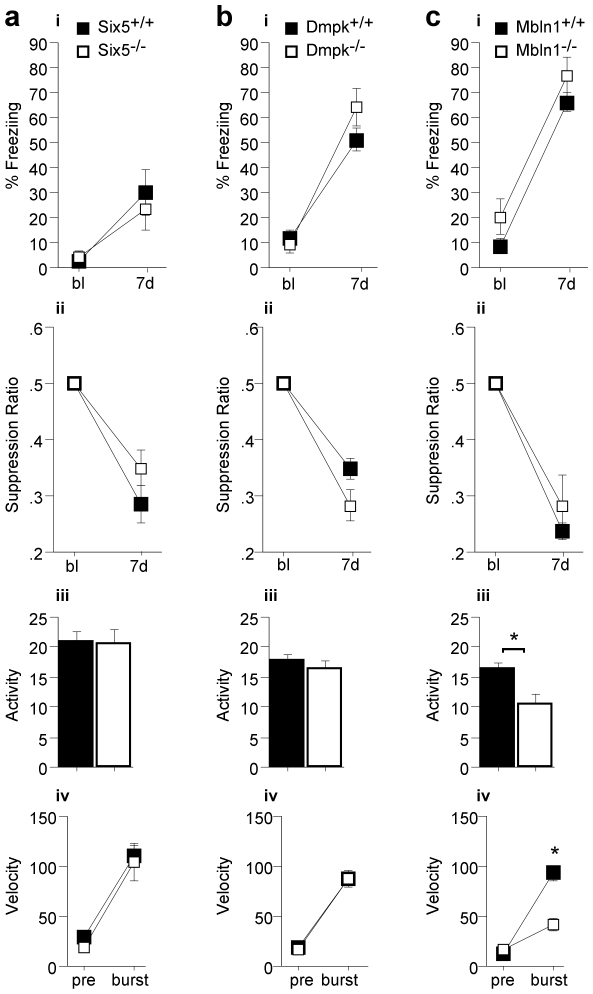
Inactivation of Six5, Dmpk or Mbnl1 does not affect Pavlovian contextual fear conditioning.The percent time freezing (panels i) and the activity suppression ratios (a ratio of locomotor activity levels which corrects for hyper- and hypo-activity, panels ii) are shown for baseline (bl) and 7-day (7 d) memory of context fear conditioning. Baseline activity levels (arbitrary units) prior to the foot shock (panels iii) and activity bursts (velocity, cm/s, panels iv) are shown. A) Six5−/− (white, n = 7) mutant mice display no differences in context fear conditioning freezing, activity suppression, activity level or activity burst phenotypes compared to the Six5+/+ wild type littermate controls (black, n = 6). B) Dmpk−/− (white, n = 9) mutant mice display no differences in context fear conditioning freezing, activity suppression, activity level or activity burst phenotypes compared to the Dmpk+/+ wild-type littermate controls (black, n = 9). C) Mbnl1−/− (white, n = ) mutant mice display no context fear conditioning phenotype compared to their Mbnl1+/+ wild-type littermate controls (black, panels i and ii). However, Mbnl1−/− (white) mutant mice show decreased baseline activity compared to their Mbnl1+/+ wild type controls (black, panel iii) (F(1,14) = 6.86, p = 0.020). Mbnl1−/− (white, n = 5) mice also display a deficit in their unconditioned response to foot shock (activity burst) compared to their wild type controls (black, n = 12, panel iv) (effect of activity burst x genotype, repeated measures ANOVA F(1,14) = 15, p = 0.0018).